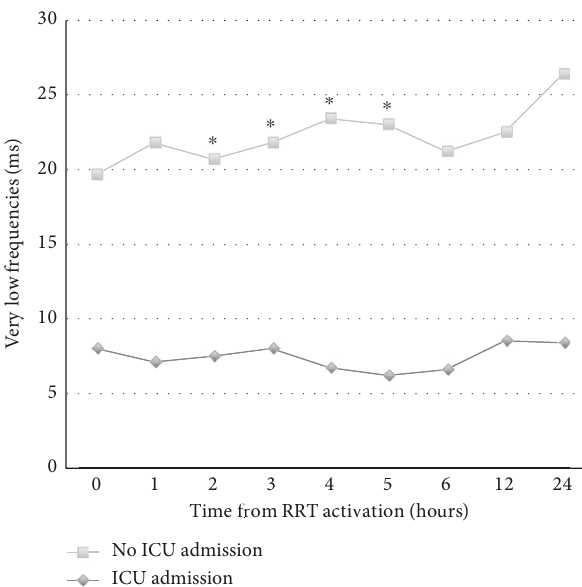
Figure 1: Trajectories of very low frequency domains between patients requiring and not requiring ICU admission.